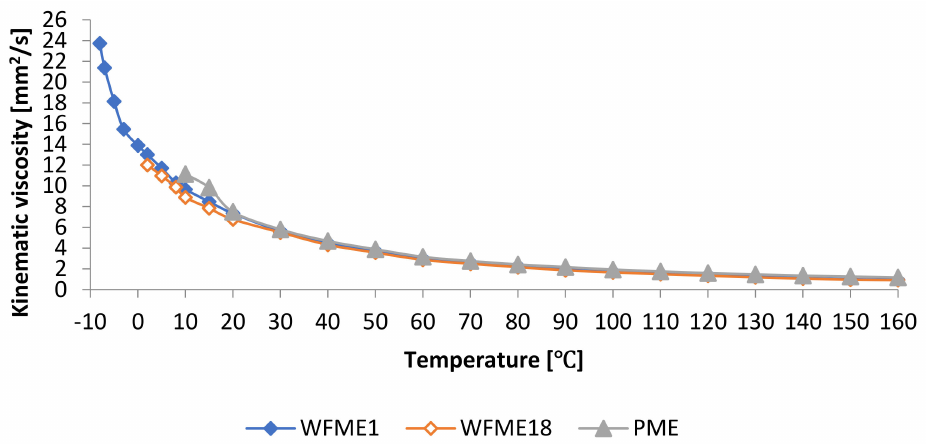
Figure 2. Kinematic viscosity–temperature relationship for selected biodiesel samples.